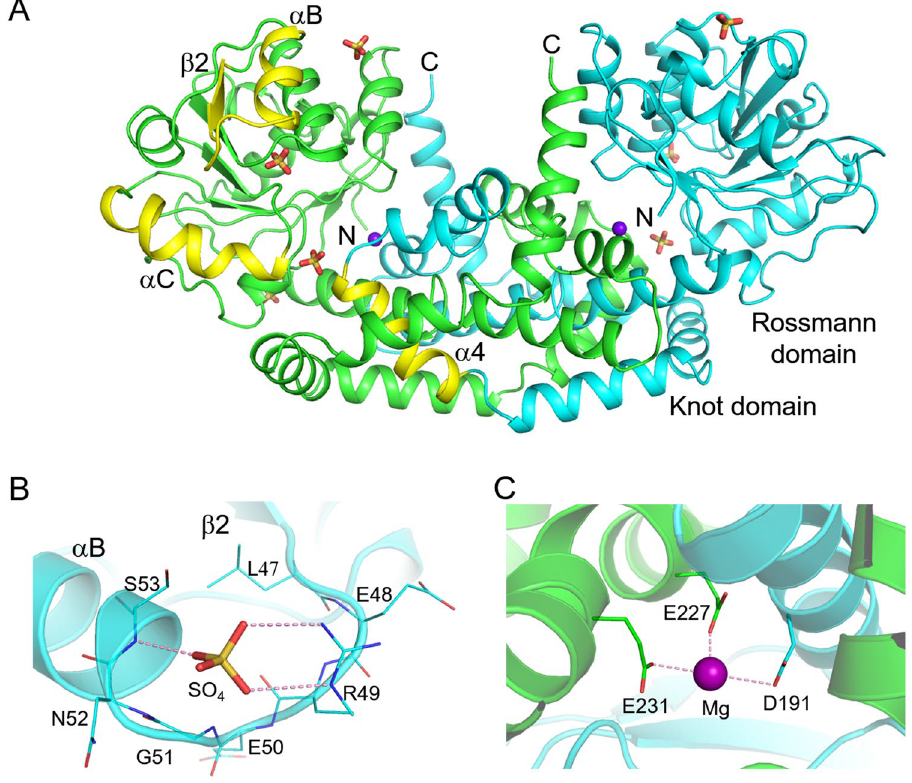
Figure 3. Crystal structure of Sac-KARI. ( A ) A dimer comprising the asymmetric unit is shown as a ribbon model with the monomers coloured green and cyan. The N and C termini are indicated, as are the Rossmann and knot domains and a few secondary structural elements of interest, which are coloured yellow. The bound sulphate and magnesium ions are shown as stick-and-sphere models. ( B ) The second sulphate interacts with the β 2- α B loop. It can form hydrogen bonds with R49 and S53, as does the 2 ′ -phosphate of NADPH. ( C ) Magnesium binding. The bound magnesium ion is shown as a purple sphere. The surrounding acidic side chains are shown as stick models. D191 is from the second monomer, which is coloured cyan rather than